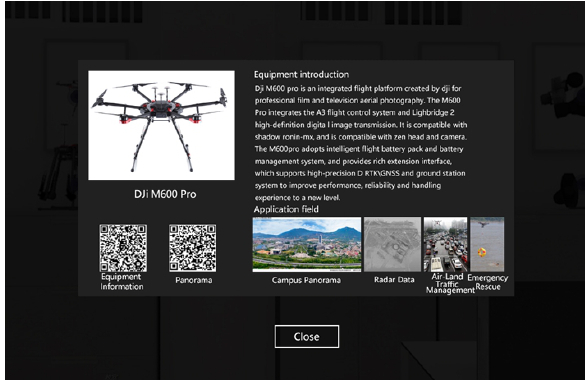
Figure 4. DJI M600 Pro knowledge show